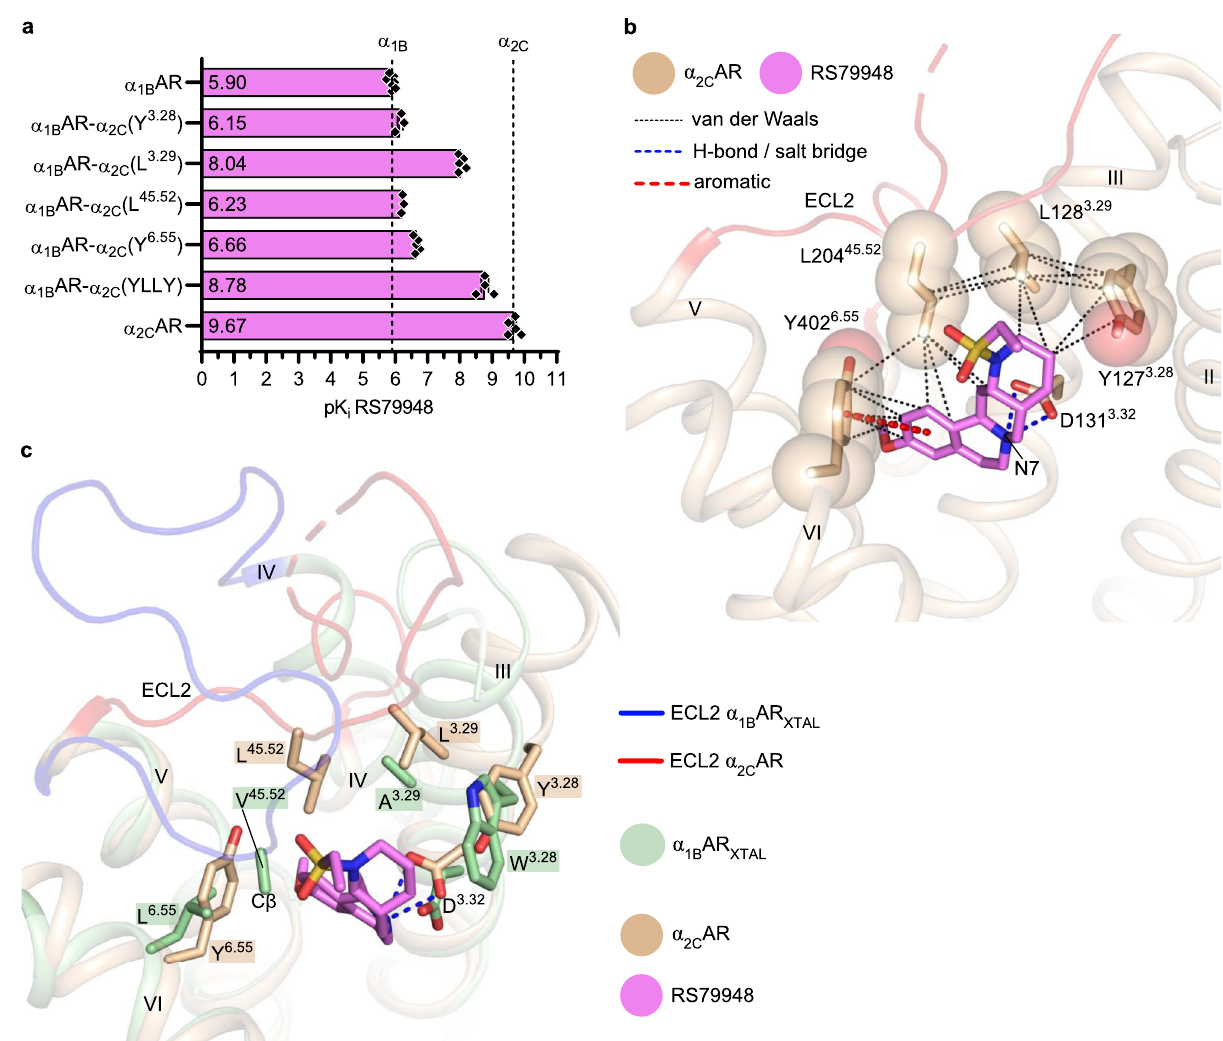
Fig. 4 Molecular determinants and structural basis for the selective binding of RS79948 to α 2C AR over α 1B AR. a Af fi nity of RS79948 for α 1B AR, α 2C AR, and chimeric α 1B AR- α 2C mutants. Single amino acid substitutions in α 1B AR are indicated in the construct names and correspond to the α 2C AR sequence at either one of positions 3.28, 3.29, 45.52, or 6.55. The α 1B AR- α 2C (YLLY) chimera corresponds to the quadruple mutant. Data are shown as mean values ± standard error of the mean (SEM) of 3 – 6 independent experiments performed in triplicate. The underlying data points are depicted as black diamonds, and the exact n, SEM, and 95% con fi dence interval of the mean are reported in Supplementary Table 6. Differences in af fi nities were evaluated by a statistical test as detailed in Supplementary Table 7. b Structural role of Y127 3.28 , L128 3.29 , L204 45.52 , and Y402 6.55 in the binding of RS79948 to α 2C AR (PDB ID: 6KUW 26 ). TM1, ECL3, and TM7 have been omitted for clarity. Receptor residues are shown as van der Waals spheres and as sticks, except for D131 3.32 , which is shown as sticks only; RS79948 is shown as sticks. Oxygen, nitrogen, and sulfur atoms are depicted in red, blue, and yellow, respectively. c Superposition of α 1B AR XTAL bound to ( + )-cyclazosin and α 2C AR-RS79948 (PDB ID: 6KUW 26 ), focusing on the residues outlined in panel b. only because its side chain is not resolved in the electron density map. Source data are provided as a Source Data fi